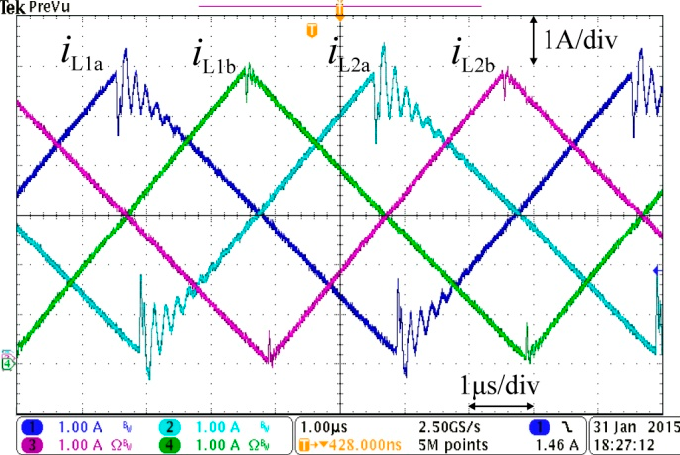
Figure 10. Waveforms of the inductor currents in the DC-DC converter operating with inductors made in a classic way ( L 1a , L 2a ) and with inductors made with the proposed method ( L 1b , L 2b ).